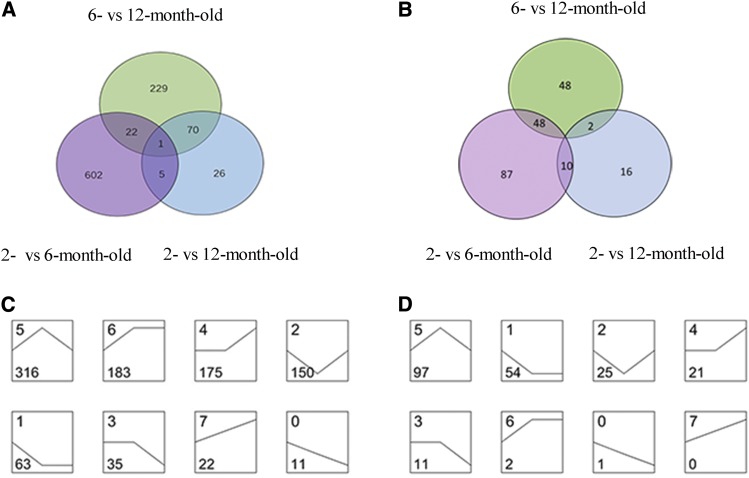
Venn and series-cluster analyses of DE mRNAs and DE miRNAs in 2-, 6-, and 12-month-old testes. a. Venn diagram of DE mRNAs in 2- vs. 6-, 6- vs. 12-, and 2- vs. 12-month-old testes. b. Venn diagram of DE miRNAs in 2- vs. 6-, 6- vs. 12-, and 2- vs. 12-month-old testes. c. Eight profiles of DE mRNAs in 2-, 6-, and 12-month-old testes. d. Eight profiles of DE miRNAs in 2-, 6-, and 12-month-old testes. Profile number is shown at the top left corner of each square. Number of DE mRNAs or miRNAs grouped in each profile is shown at the bottom left corner of each square. Profiles are ordered based on the number of mRNAs or miRNAs assigned.